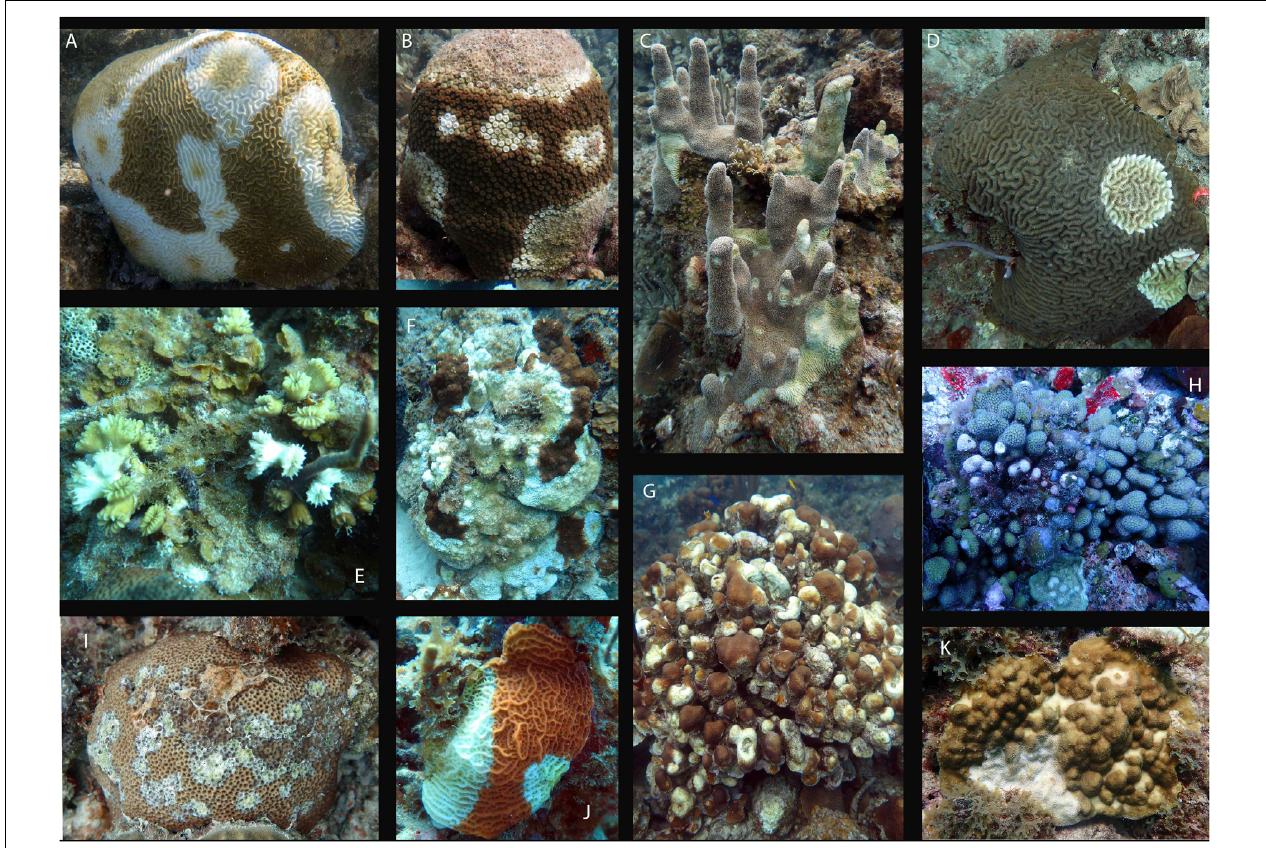
FIGURE 3 | Images of SCTLD-affected colonies of coral multiple species. Acute tissue loss disease signs consistent with SCTLD on coral species shown to be affected in first surveys at long-term monitoring locations around St. Thomas, VI. Species include: (A) Pseudodiploria strigosa , (B) Montastraea cavernosa , (C) Dendrogyra cylindrus , (D) Colpophyllia natans , (E) Eusmilia fastigiata , (F) Orbicella franksi, (G) Orbicella annularis , (H) Madracis spp., (I) Siderastrea siderea , (J) Agaricia spp., (K) Porites astreoides . Image credits: panle (A) J. Townsend, panel (B–K) M.